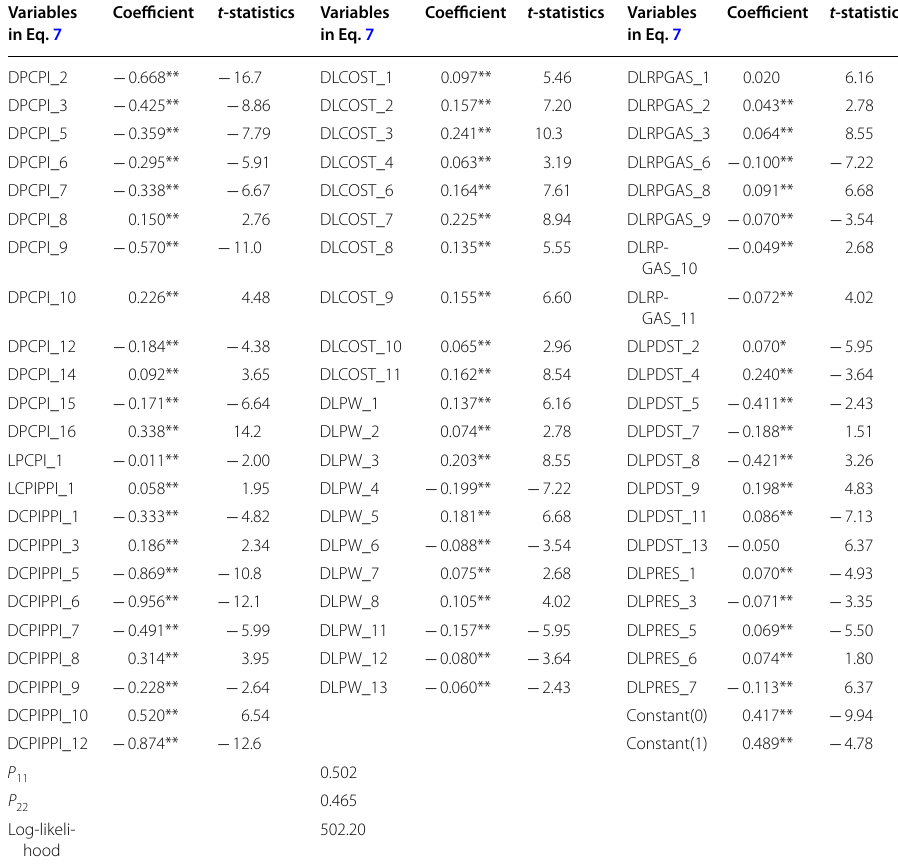
Table 3 Dynamic disequilibrium switching Variables in Eq.